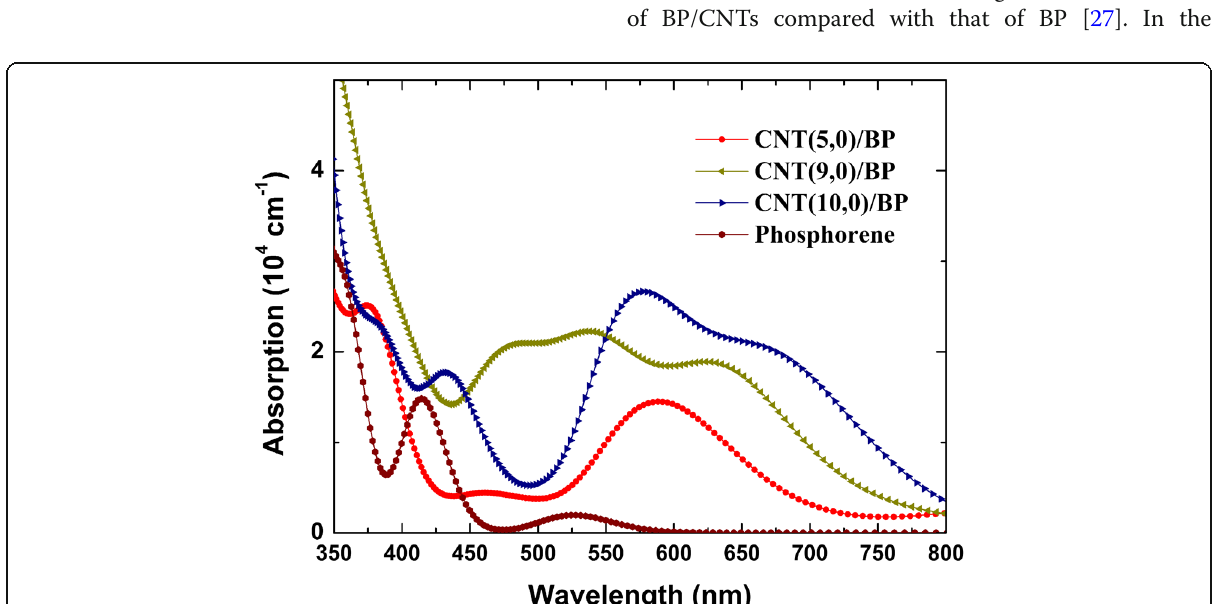
Fig. 7 Calculated absorption spectra of the CNT/BP hybrids and pure monolayer